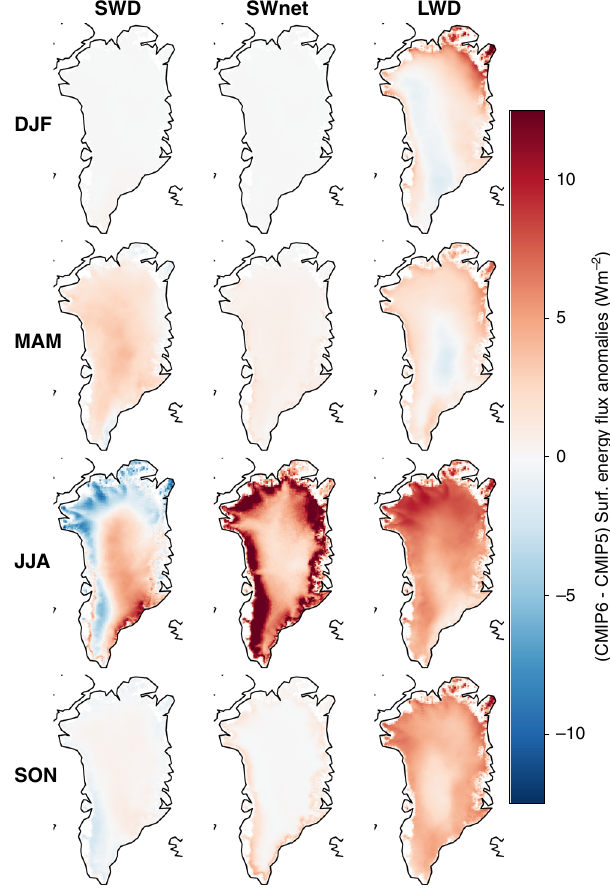
Fig. 7 Difference in surface energy budget fl uxes between CMIP6 and CMIP5 MAR simulations (2071 – 2100). Thirty-year average (2071 – 2100) difference SSP585 – RCP8.5) in incoming longwave and shortwave radiation, in addition to the absorbed shortwave radiation difference in W/m 2 . Positive values indicate a greater downwelling or absorbed fl ux in CMIP6 SSP585 (red colors), while negative values indicate lower fl uxes towards the surface in CMIP6 (blue colors). The rows indicate the difference seasons, from winter (DJF) at the top, spring (MAM), summer (JJA) and fall at the bottom (SON). In addition, the columns indicate the different components of the radiative fl uxes, namely incoming shortwave (SWD), absorbed shortwave (SWnet), and incoming longwave radiation